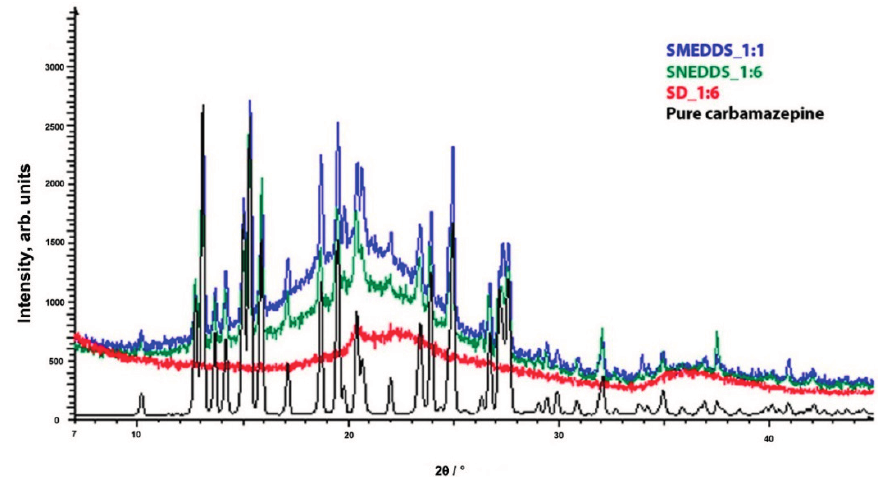
Figure 4. PXRD patterns of evaluated formulations and pure